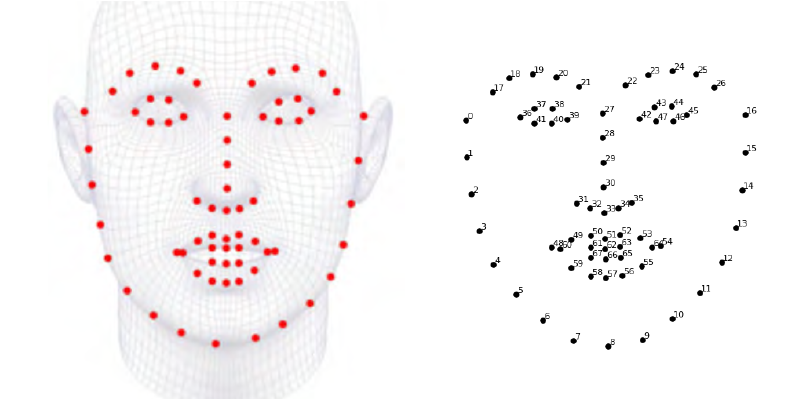
Figure A1. Illustration of the 68 face landmarks. Adapted from